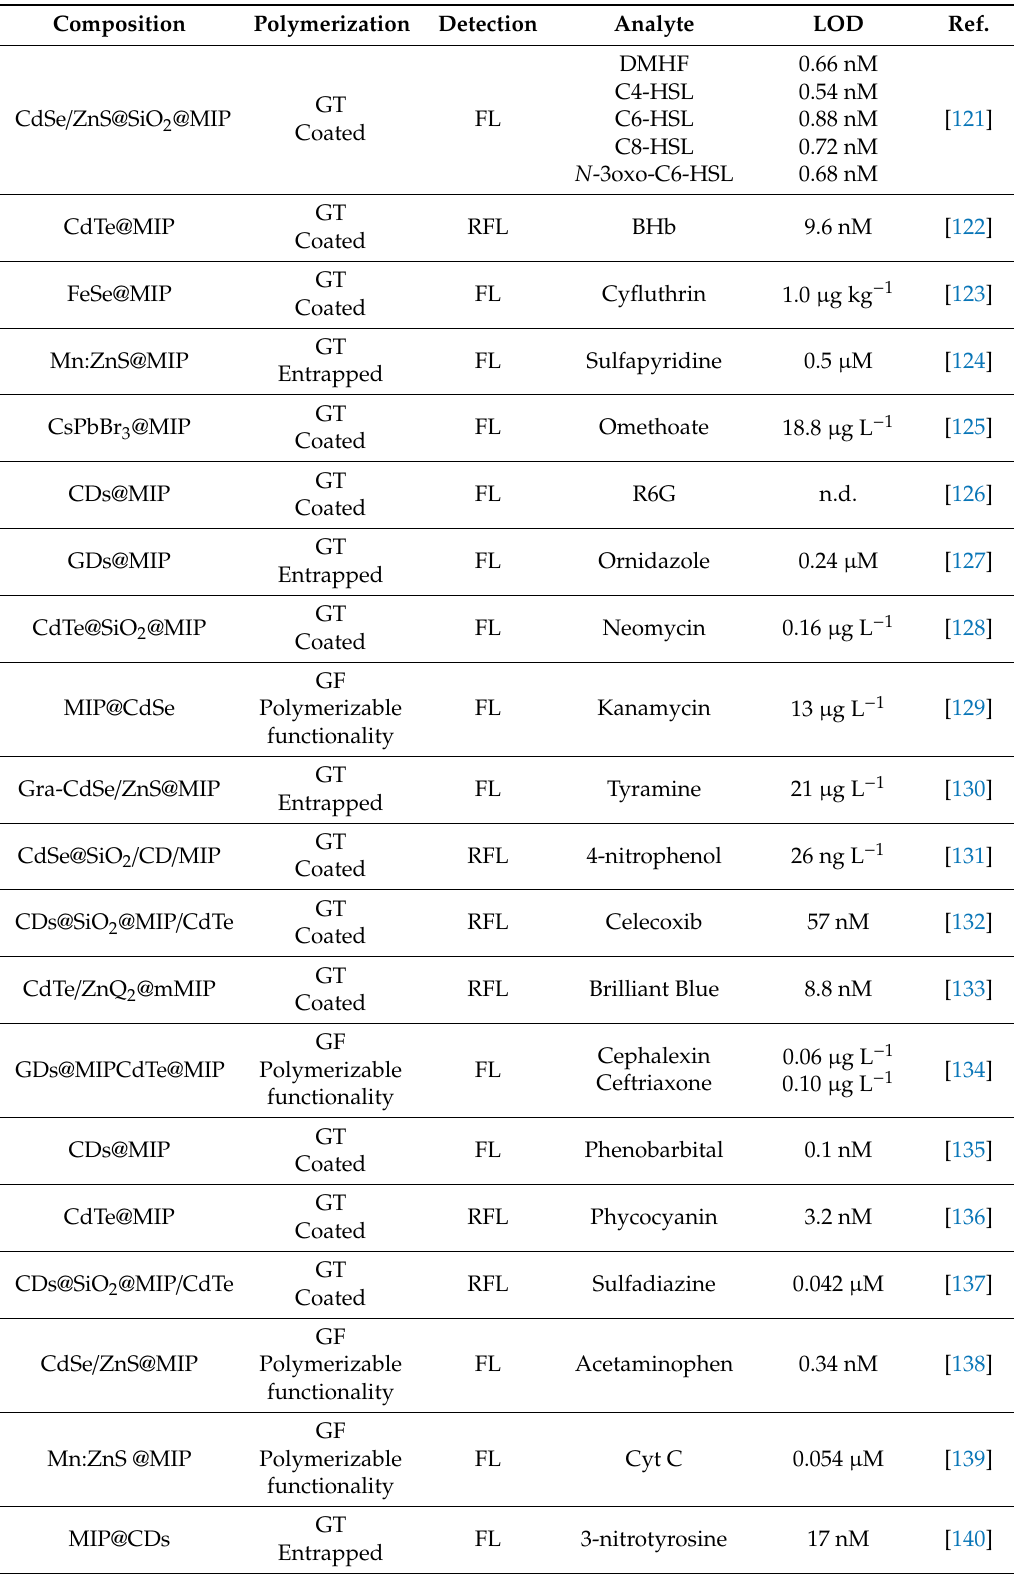
Table 7. Optical sensors based on core-shell MIPs with a quantum dot core. Composition Polymerization Detection Analyte LOD